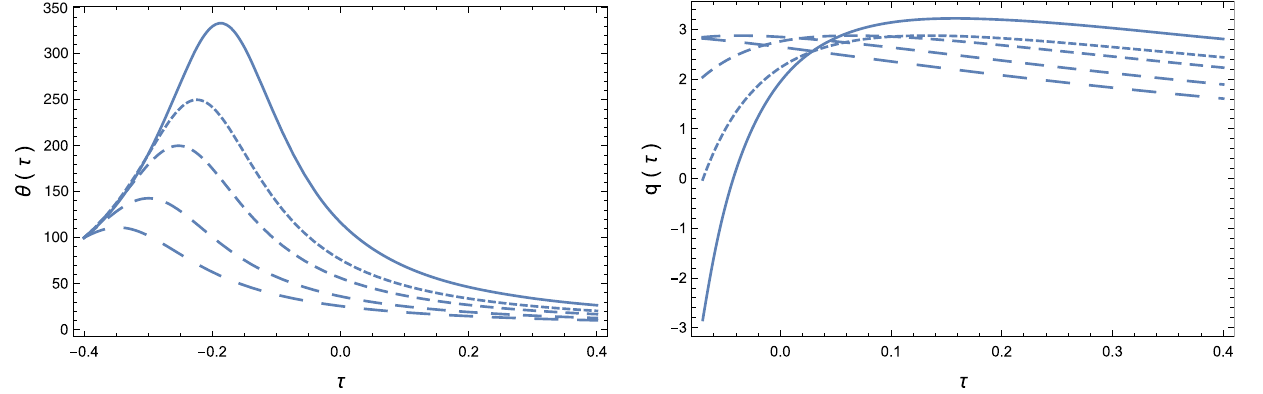
Fig. 2 Time evolution of the dimensionless temperature θ (left figure) and of the deceleration parameter q (right figure) in a loop quantum cosmological Universe filled with a deformed photon gas with the dis- persion relation E = kc ( 1 + λ E ) , with λ k B T >> 1, for different val- ues of the parameter A 1 : A 1 = 3 × 10 − 3 (solid curve), A 1 = 4 × 10 − 3